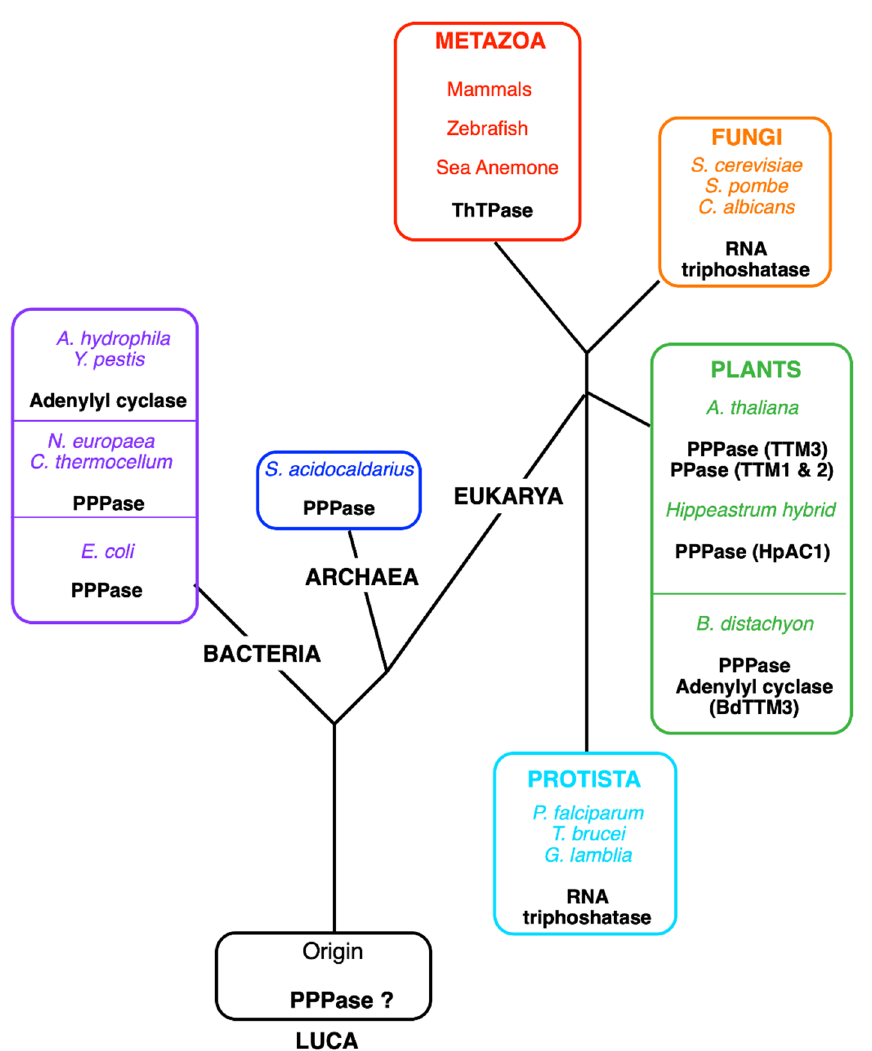
Figure 4. Tentative phylogenetic tree of the TTM (CYTH) superfamily. Currently, five different enzyme activities have been identified for members of the CYTH superfamily: tripolyphosphatase in bacteria ( C. thermocellum , N. europaea , E. coli ), an Archaea ( Sulfolobus acidocaldarius) and plants ( A. thaliana and Hippeastrum hybrids), adenylyl cyclase (in A. hydrophila and Y. pestis ), RNA triphosphatase (in fungi and some protozoans), and ThTPase (in most metazoans, including vertebrates except for birds). Lately, pyrophosphatase activity (PPase) was recognized in A. thaliana TTM1 and TTM2, proteins containing a TTM and a uridine kinase domain [87]. The plant B. distachyon (BdTTM3) shares high triphosphatase activity and low adenylyl cyclase activity [84]. We hypothesize that the original activity in the Last Universal Common Ancestor (LUCA) was the hydrolysis of low molecular mass polyphosphates.